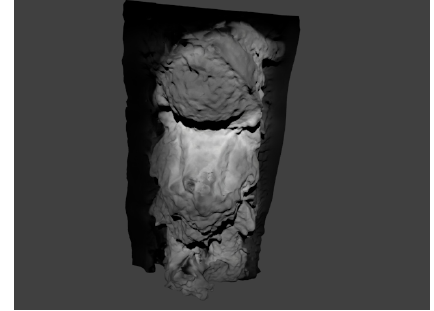
Figure 1. Example of 3D reconstruction in the thermal